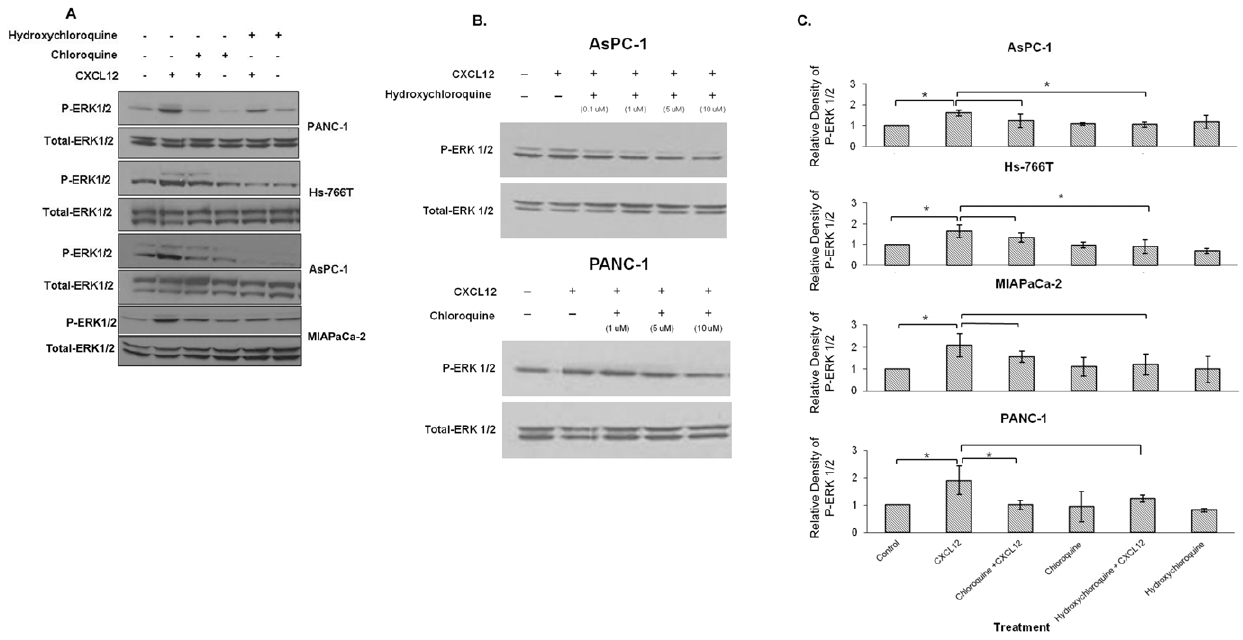
Figure 5. Chloroquine and hydroxhychloroquine inhibit CXCL12-mediated ERK phosphorylation. (A) Immunostaining for phospho-ERK was performed for PANC-1, Hs-766T, AsPC-1, and MIAPaCa-2 cell lysates. Cells were pretreated with chloroquine or hydroxychloroquine (0.1 m M) for 30 minutes after which cells were exposed to CXCL12 (200 ng/ml) for 20 minutes. An antibody to total ERK1/2 was used as a loading control. The CXCL12-mediated increases in phospho-ERK were effectively abrogated with either chloroquine or hydroxychloroquine. (B) Pretreatment of PANC-1 and AsPC-1 cells with chloroquine and hydroxychloroquine (0.1–10 m M) for 5 minutes followed by exposure to CXCL12 (200 ng/ml) demonstrate dose-dependent effects of drug treatment on CXCL12-mediated ERK phosphorylation. (C) Western blots were scanned and quantified using the AlphaImager Tm3400 (Alpha Innotech). Fold changes for phospho-ERK compared to untreated controls were calculated as relative expression, which was normalized to protein band intensities of total ERK. The data shows the mean of triplicate experiments, with p -values , 0.05 considered statistically significant.